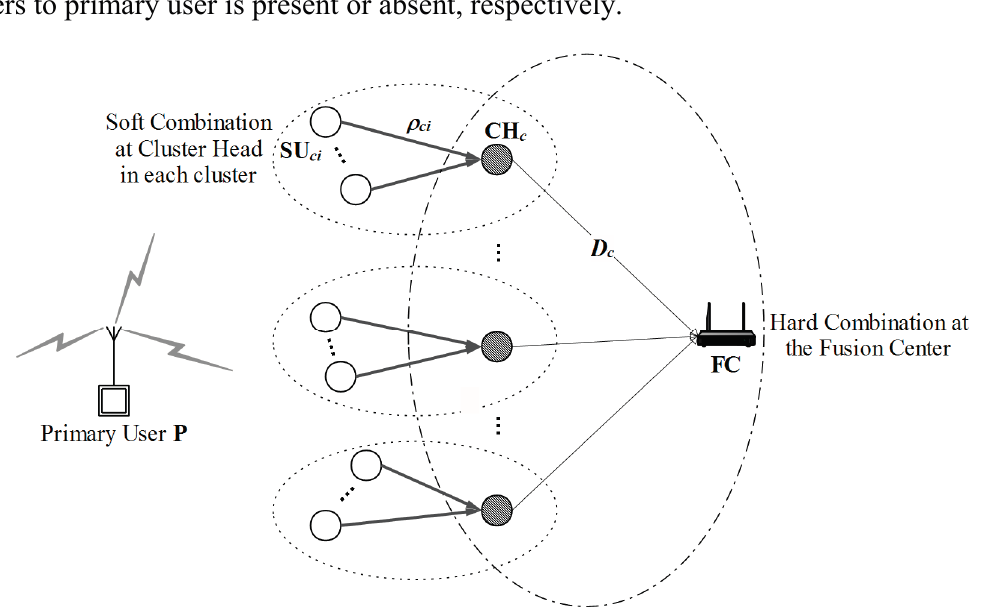
Figure 1. The soft-hard combination (SHC) scheme in which P represents the primary user, SU ci represents the i- th SU in the c- th cluster, ρ ci represents its local test statistic which is the received energy contents of the primary signal, CH c represents the c- th cluster head, D c represents its one bit cluster decision, and FC represents the fusion